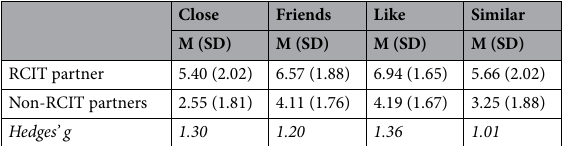
Table 1. Means, standard deviations, and effect sizes of the relationship closeness induction task for different manipulation check items. Hedge’s g represents the difference between participants’ responses for RCIT partners and non-RCIT partners in standard deviation